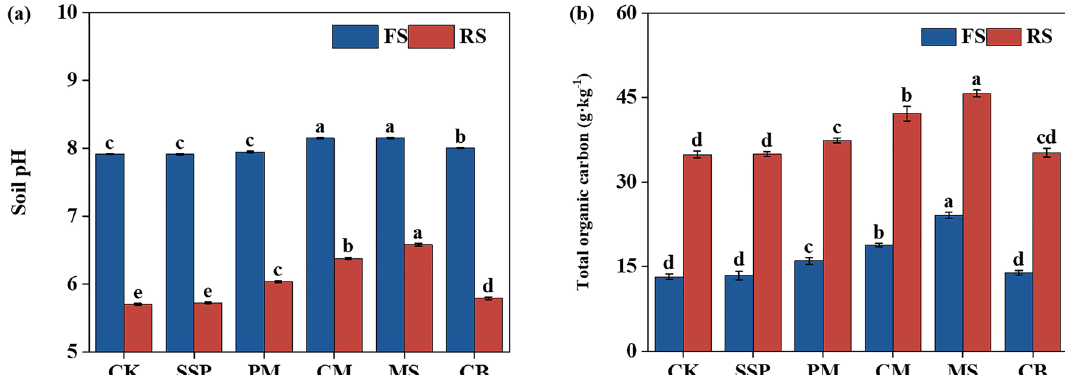
Figure 4. Soil pH ( a ) and total organic carbon (TOC) ( b ) of fluvo-aquic and red soils with different alternative P sources on DAI 70. FS: Fluvo-aquic soils; RS: Red soils; CK: Control; SSP: Ca(H 2 PO 4 ) 2 ; PM: Poultry Manure; CM: Cattle Manure; MS: Maize Straw; CB: Cattle Bone Meal. Different lowercase letters indicate significant differences among the P sources. Significant at P < 0.05. The error bar represents